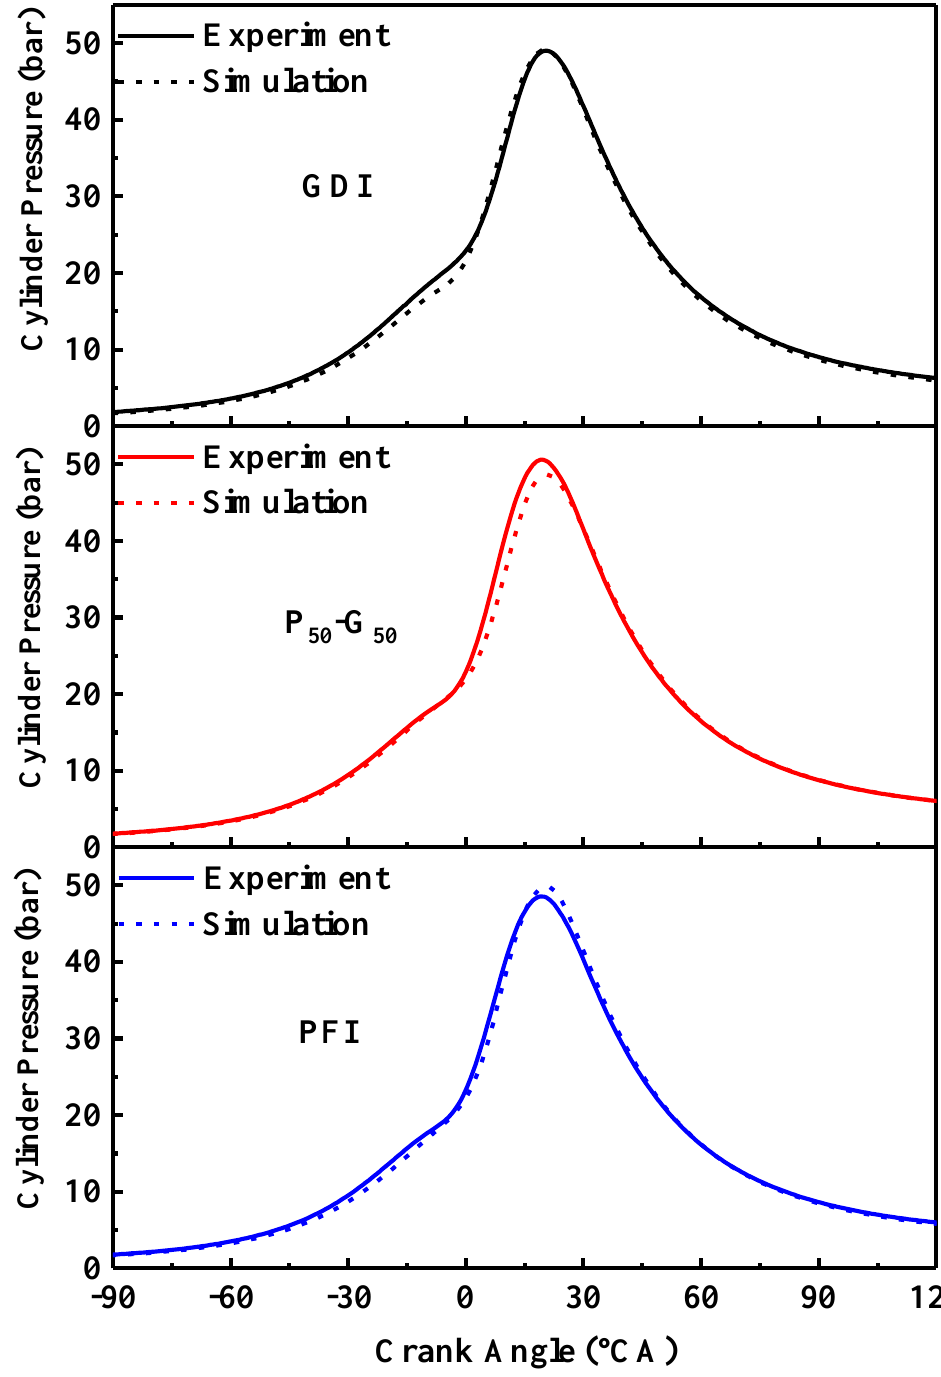
Figure 5. Comparison of cylinder pressure between experimental and simulation results at 2000 rpm-10 bar.